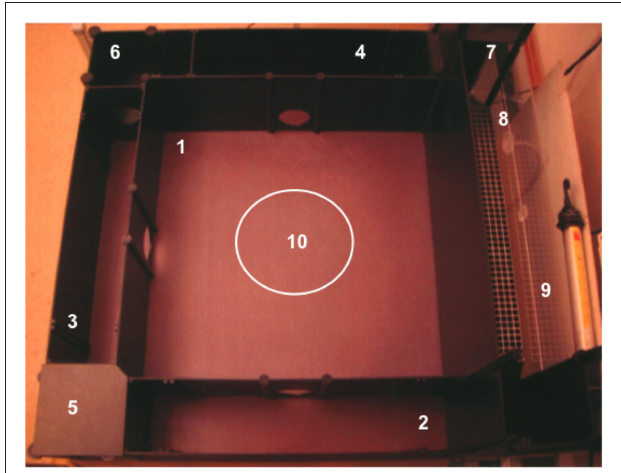
Figure 1 | The MCSF test. The numbers indicate the defined zones CENTER (#1), CORRIDORs (#2–4), dark corner room (DCR; #5), HURDLE (#6), SLOPE (#7), BRIDGE ENTRANCE (#8), BRIDGE (#9), and CENTRAL CIRCLE